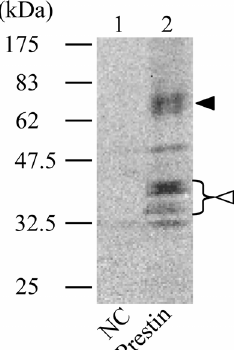
Fig. 1 Confirmation of prestin expression in Sf9 cells examined by Western blotting. Lane 1: uninfected cells (negative control). Lane 2: Infected cells. The solid arrowhead and the open arrowheads indicate prestin and fragments of degraded prestin, respectively.